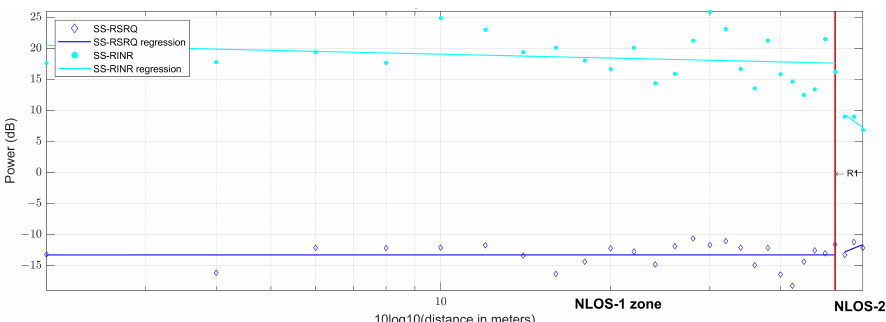
Figure 11. Experimental data of 5G SS-RSRQ and SS-RINR at 868 MHz.